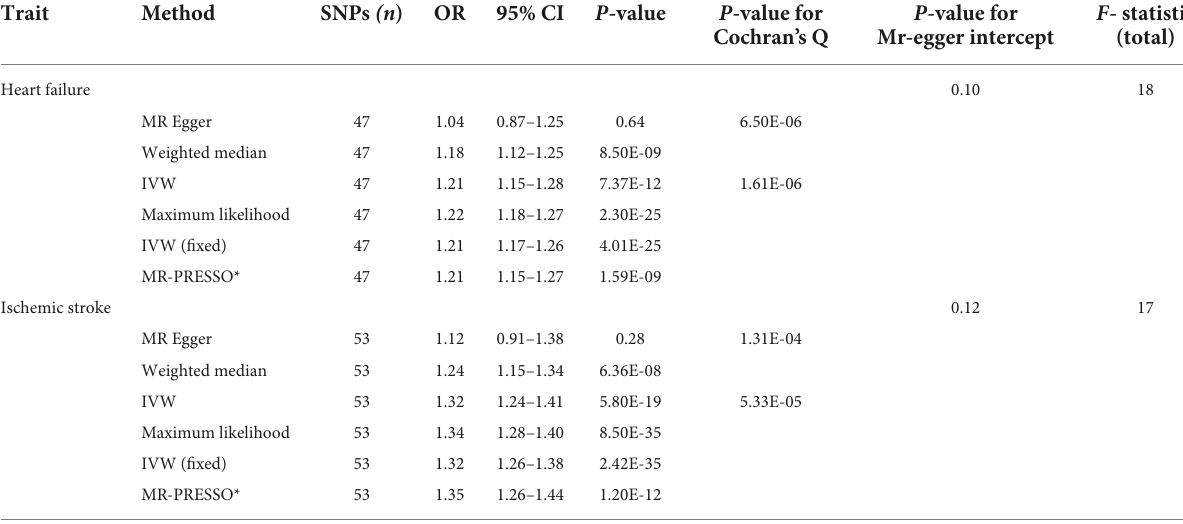
TABLE 3 Mendelian randomization estimates of hypertension on the risk for HF and IS.